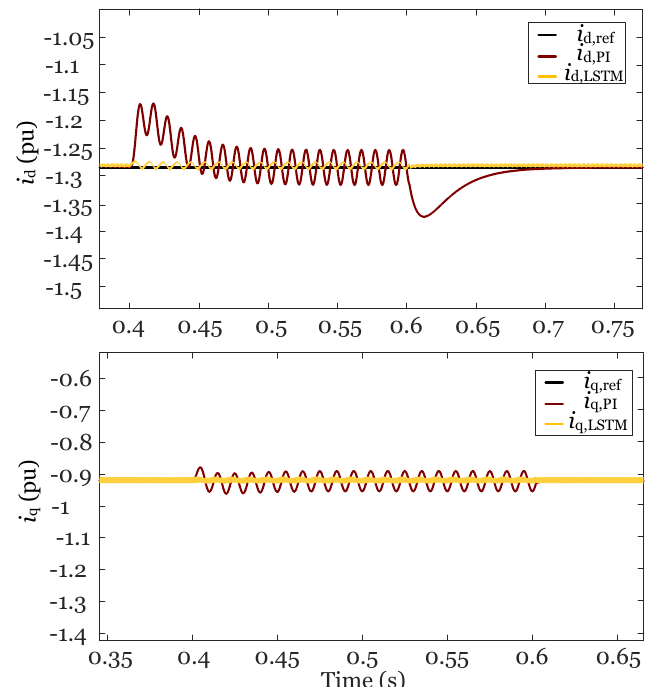
Figure 11. Controller response to a single phase-ground fault at PCC.